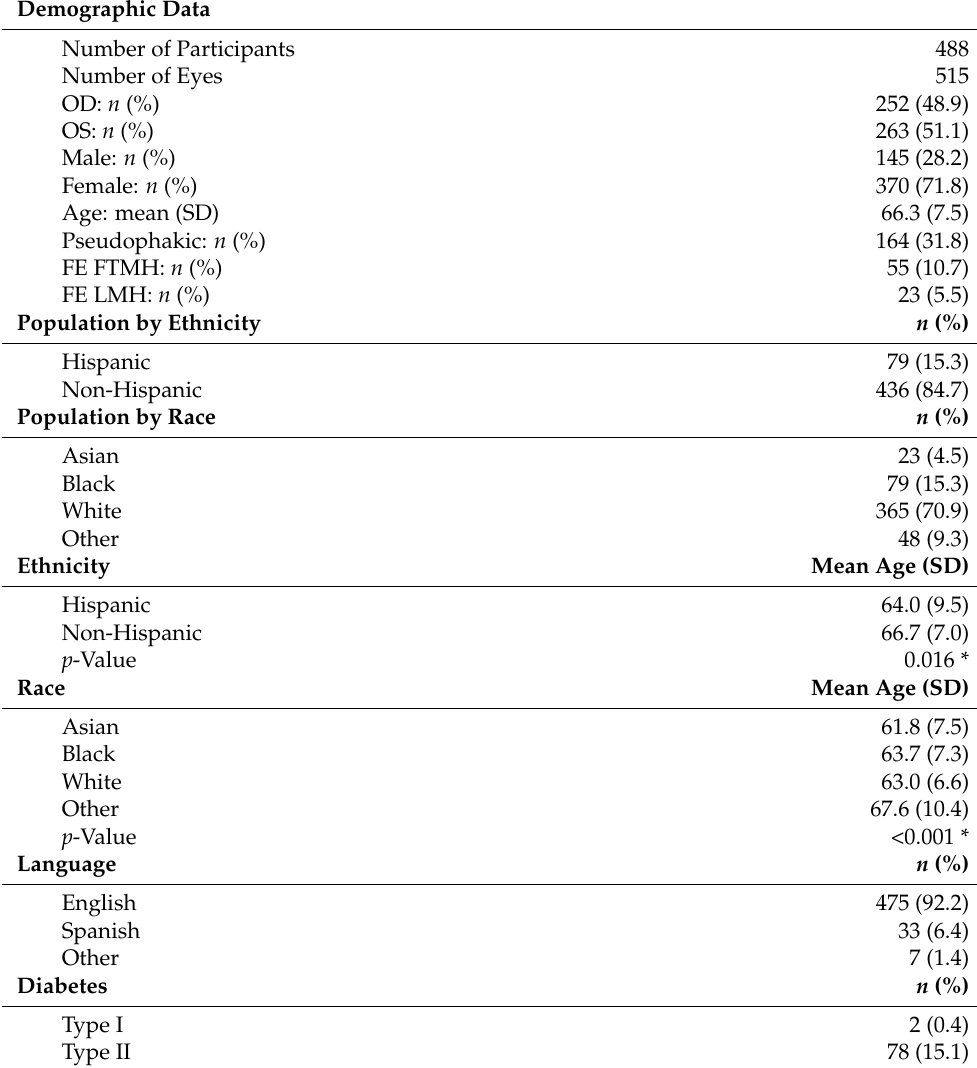
Table 1. Patient demographics and clinical